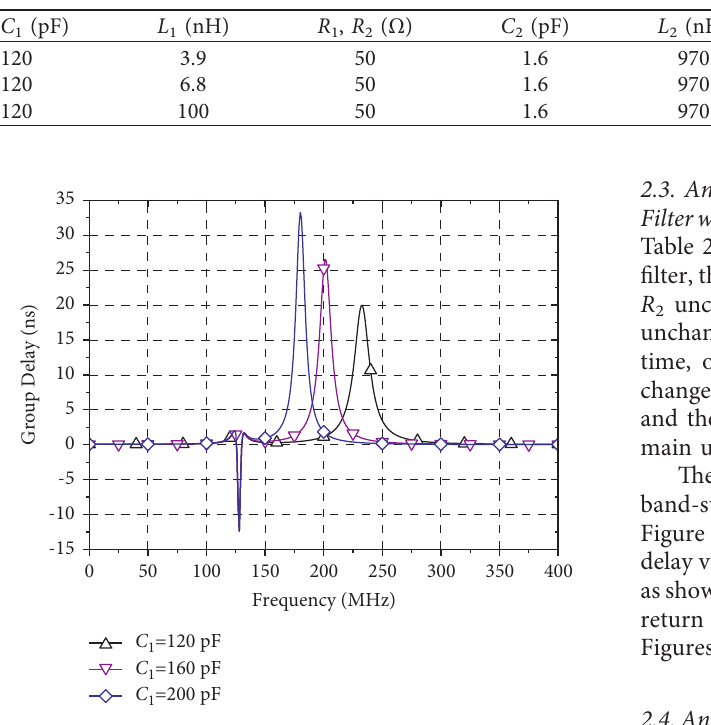
Figure 8: Negative delay of band pass in the band-stop filter with different C 1